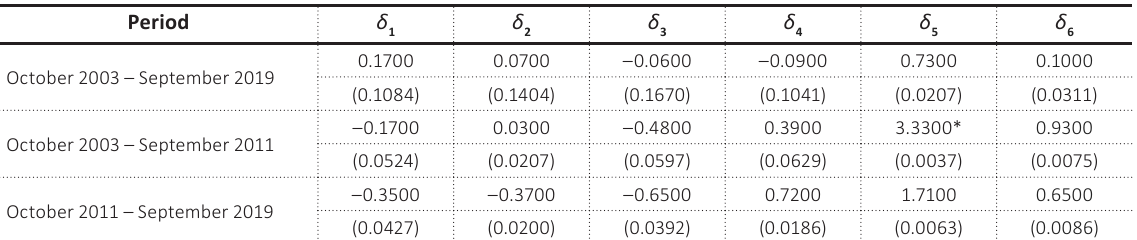
Note: This table contains estimated z values for the risk premia along with the associated standard errors, which are mentioned in the parentheses, δ